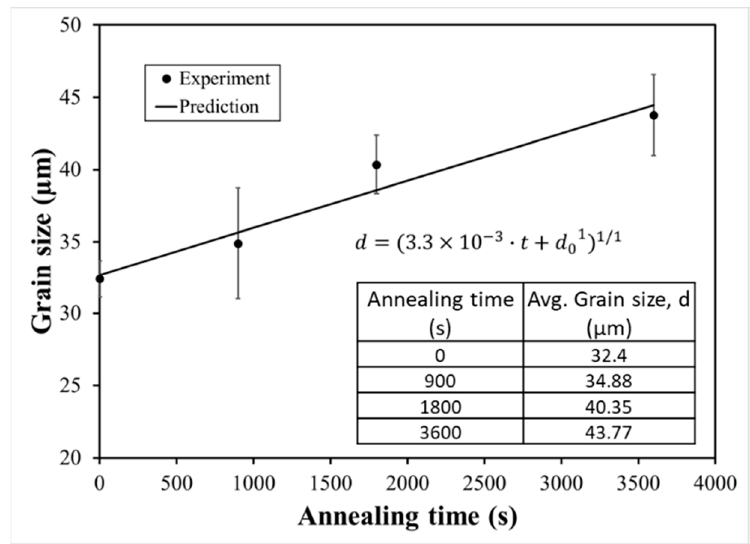
Figure 2. Grain growth of 253 MA ASS during annealing at 1100 °C with variations in the annealing time.